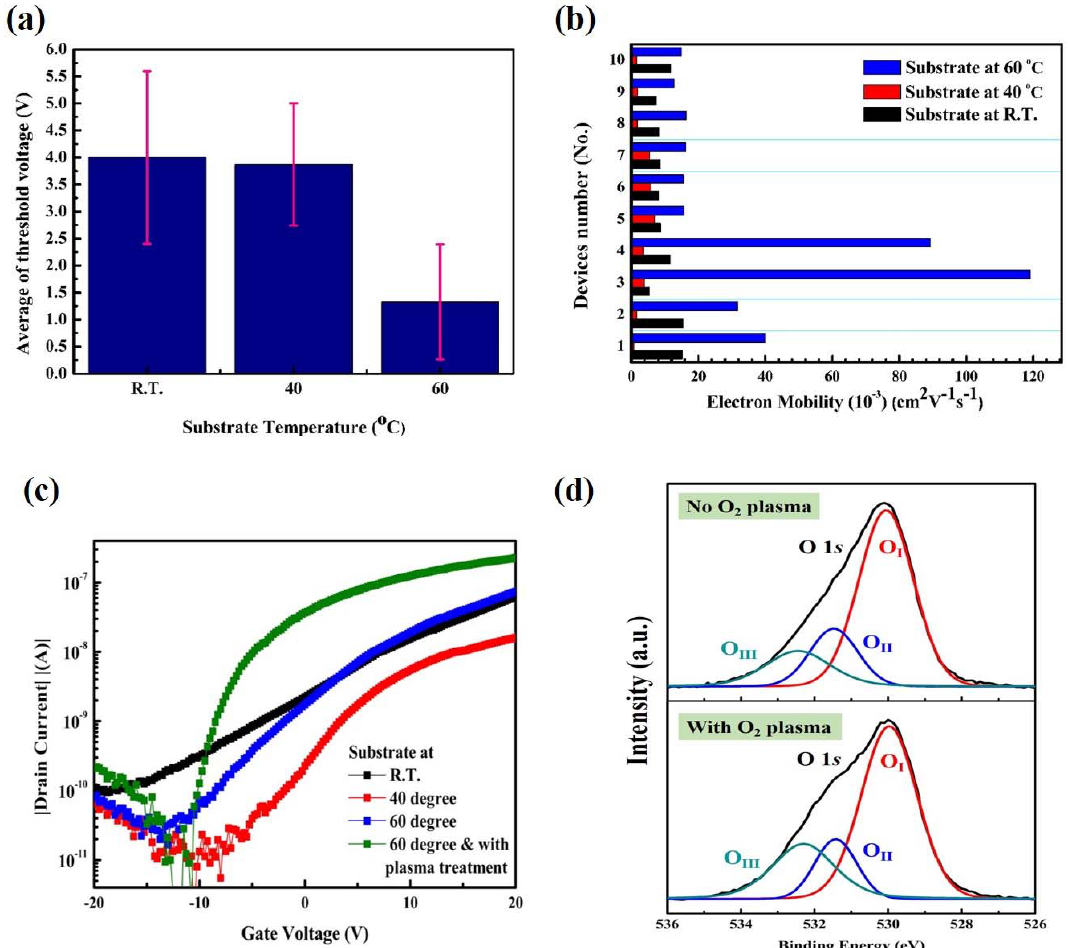
Figure 3. Electrical characterization of the ZnO ‐ based TFTs through ink ‐ jet printing in the atmosphere analyzer for measurements performed in air, where I DS was measured while V GS was scanned from − 20 V up to 20 V at a constant V DS of 5 V. ( a ) Comparison of the average values for the absolute normalized threshold voltage ( V th ) of the TFTs prepared at room temperature, 40 and 60 º C; electrical characterization of the average values was achieved from 10 TFT devices. ( b ) Comparison of the distribution of saturation electrons mobility for 10 ink ‐ jet printed TFTs. ( c ) Typical transfer characteristics of I DS – V GS . ( d ) X ‐ ray photoelectron spectroscopy (XPS) spectra of the O1s region of ZnO films with/without oxygen plasma treatment.